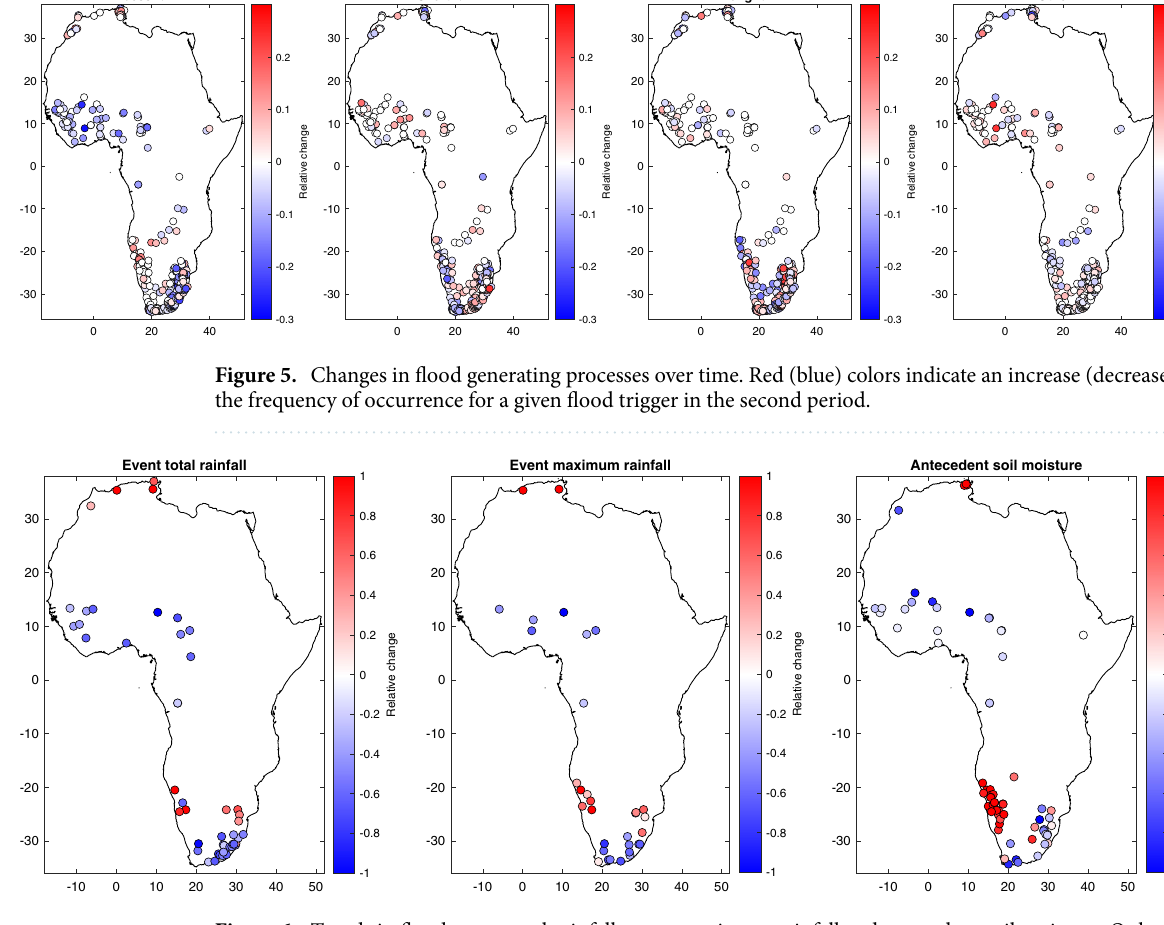
Figure 6. Trends in flood-event total rainfall, event maximum rainfall and antecedent soil moisture. Only trends significant at the 5% level are reported on the